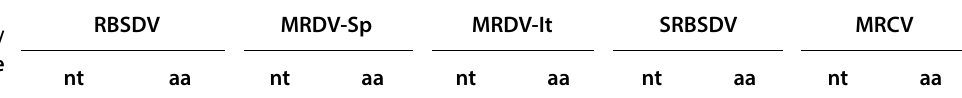
Table 3. Sequence identity (%) among species of the Fijivirus genus that infect maize at the S9 full length and ORFs at nu- cleotide and amino acids